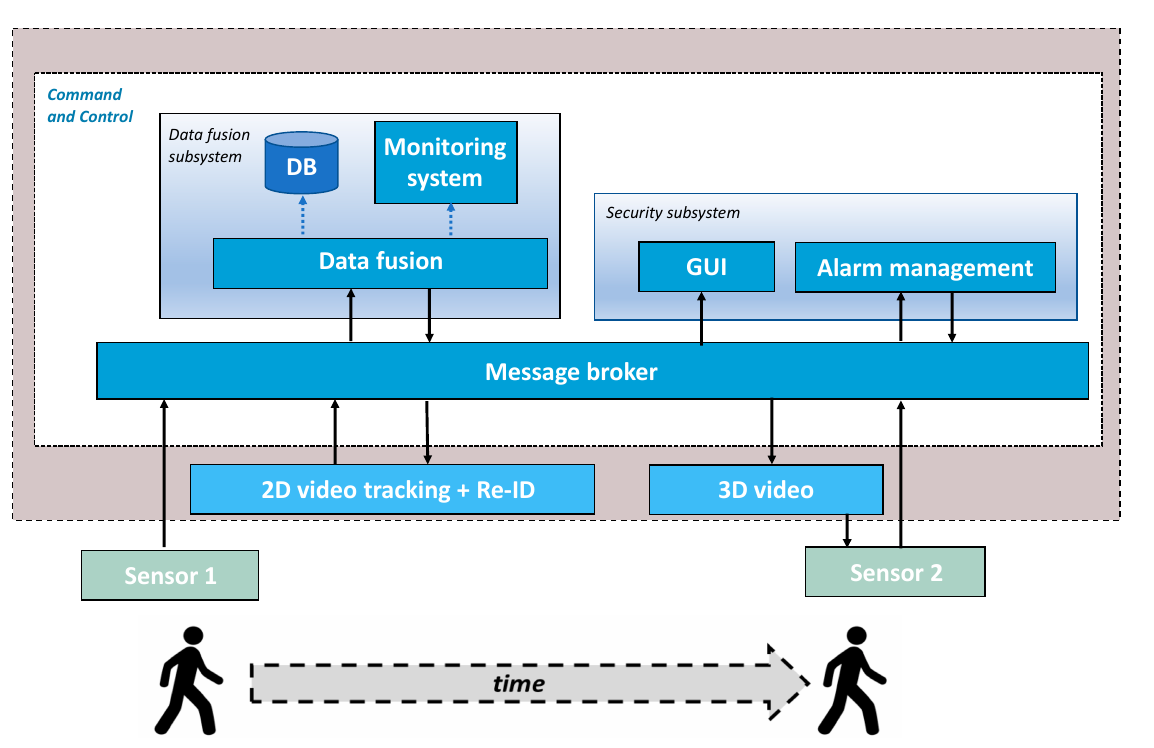
Figure 2. The C&C internal architecture within the INSTEAD framework. In DEXTER deployment, Sensor 1 is MIC, and Sensor 2 is EXTRAS .